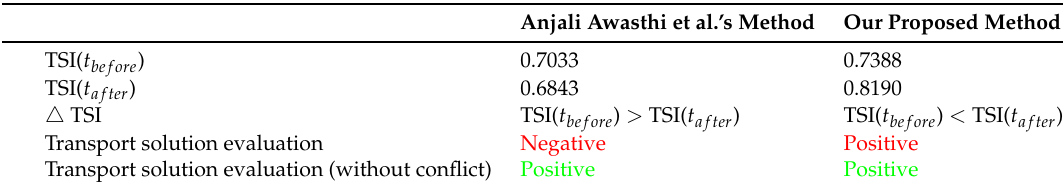
Table 10. Comparison of the two methods.